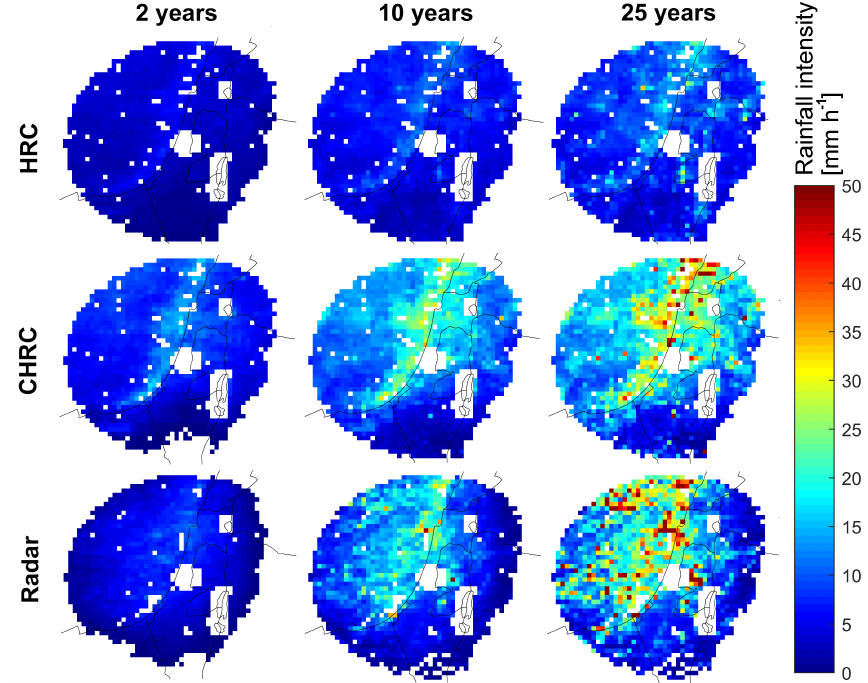
Figure 5. Example of IDF maps for 3h duration from HRC, CHRC, and radar for 2-, 10-, and 25-year return periods. Only the pixels included in the analyses are